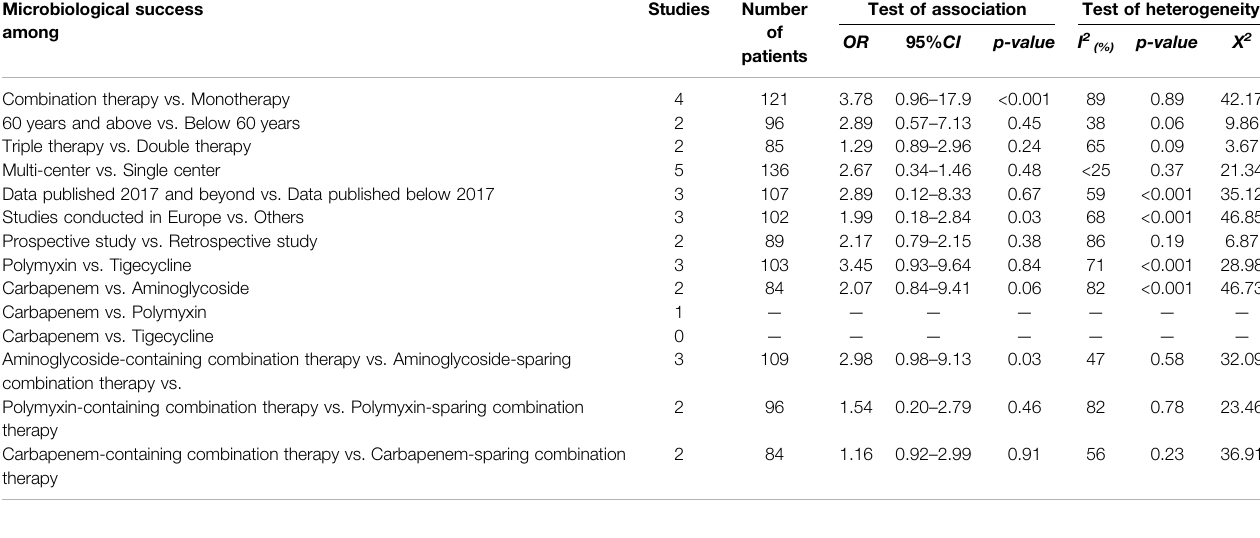
TABLE 4 | Subgroup analysis on microbiological outcomes.